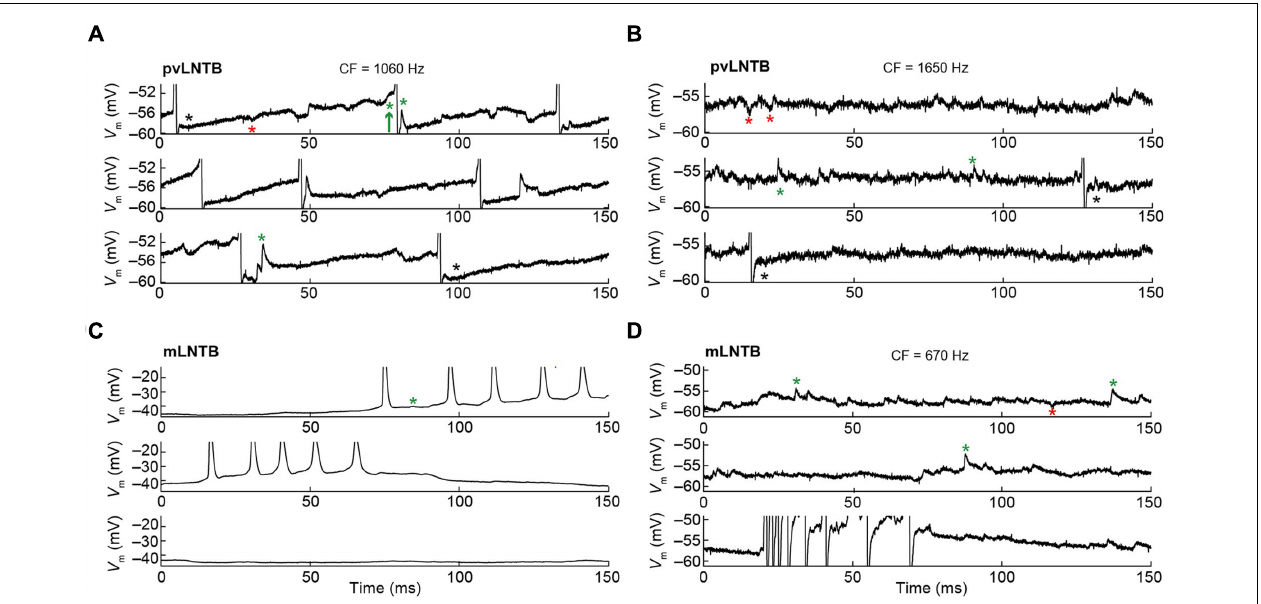
FIGURE 6 | Spontaneous activity of LNTB neurons. CF is indicated when known. (A) Spontaneous activity in a pvLNTB neuron. Black asterisks: spike afterhyperpolarization shows double undershoot, as described in gerbil slice (Roberts et al., 2014). Red asterisks: IPSPs. Green asterisks: EPSPs. Green arrow: EPSP that results in an action potential. (B) Spontaneous activity in another pvLNTB neuron. Symbols as in (A) . (C,D) Spontaneous activity in two mLNTB neurons. Symbols as in (A)